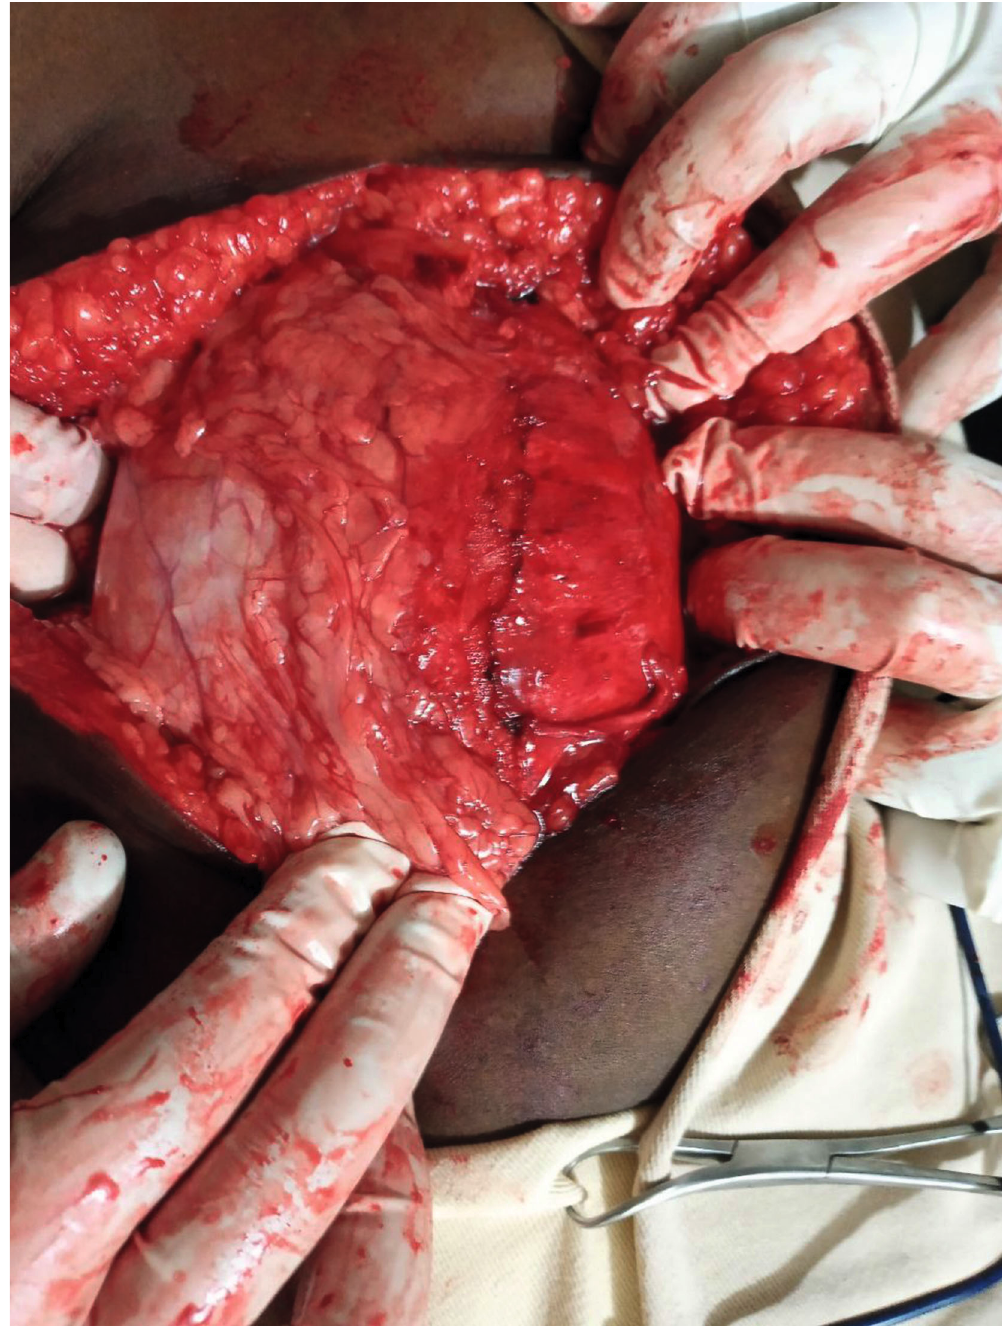
Figure 2: The mass with its abdominal wall